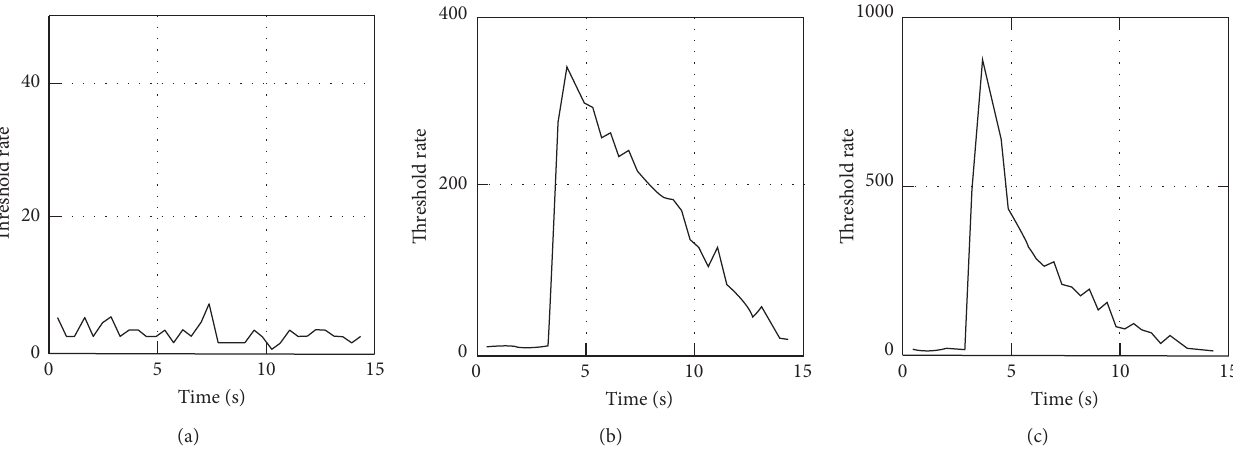
Figure 7: Short-term threshold rate distribution of different fiber vibration signals. (a) Nonintrusion. (b) Tapping. (c) Climbing.